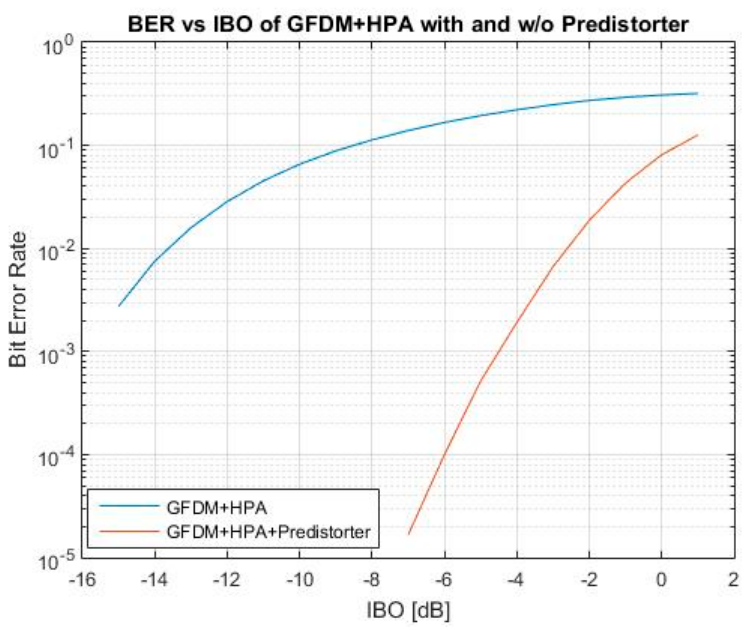
Figure 16. BER vs. IBO GFDM with and without predistorter.